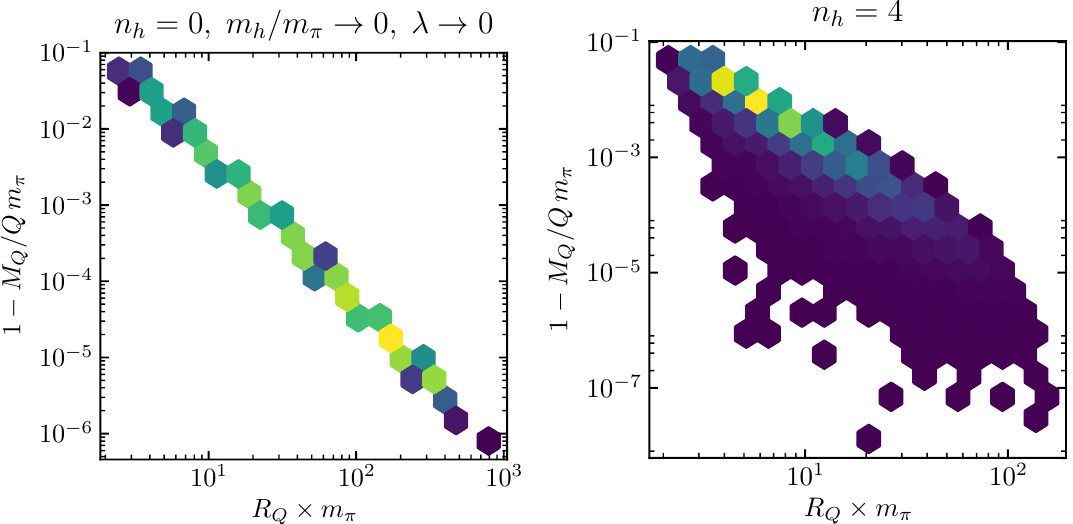
Figure 6 . The distribution of Q-ball solutions with di(cid:11)erent fractional binding energies and radii (in units of the pion mass). See caption of (cid:12)gure 3 for more